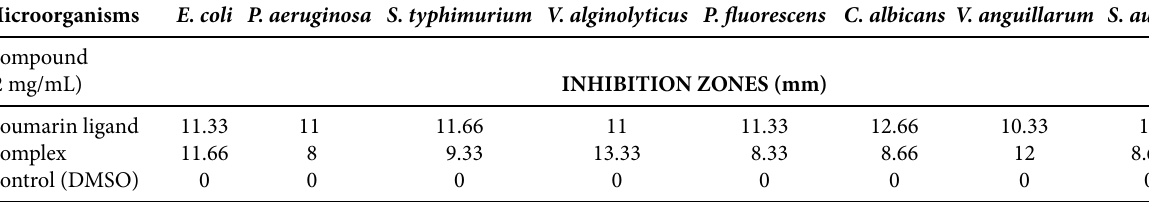
Table 4. Antimicrobial activities of the synthesized coumarin ligand and complex Microorganisms